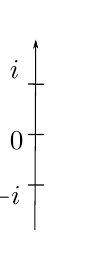
Figure 8 . Sketch of the analytic structure of the modular correlator G mod ( x, y, t ) (4.8) as function of complex modular time t , for fixed x, y belonging to a single interval on the plane or cylinder(A). The function is analytic everywhere except at its simple poles (black dots), their specific location depending on x, y . Since the modular flow in this case is local, G mod ( t ) possesses no branch cuts. For multiple intervals, the location of the poles is shifted, but no new poles arise. The KMS condition ensures that G mod is antiperiodic in imaginary time.